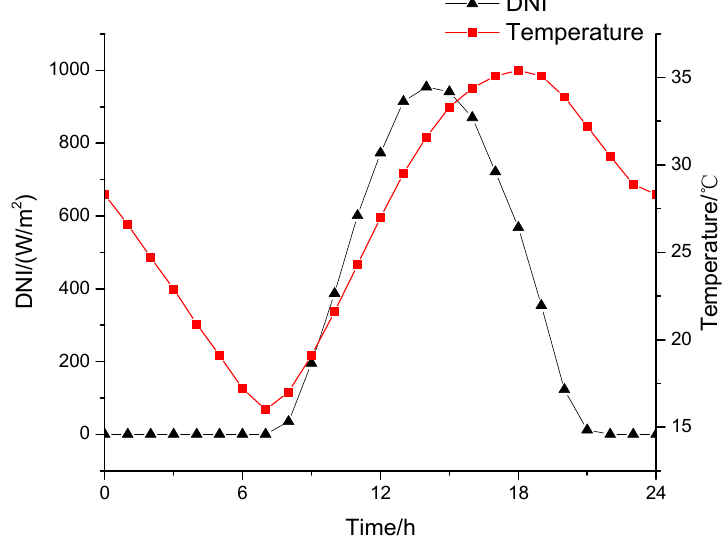
Figure 7. Meteorological data in a typical summer day.